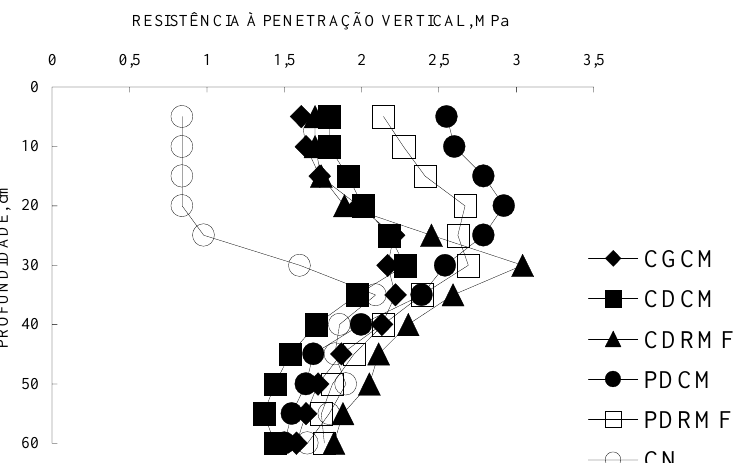
Figura 2. Resistência à penetração vertical em Latossolo Vermelho distrófico típico, em diferentes profundidades, sistemas de manejo e cerrado nativo, Sete Lagoas